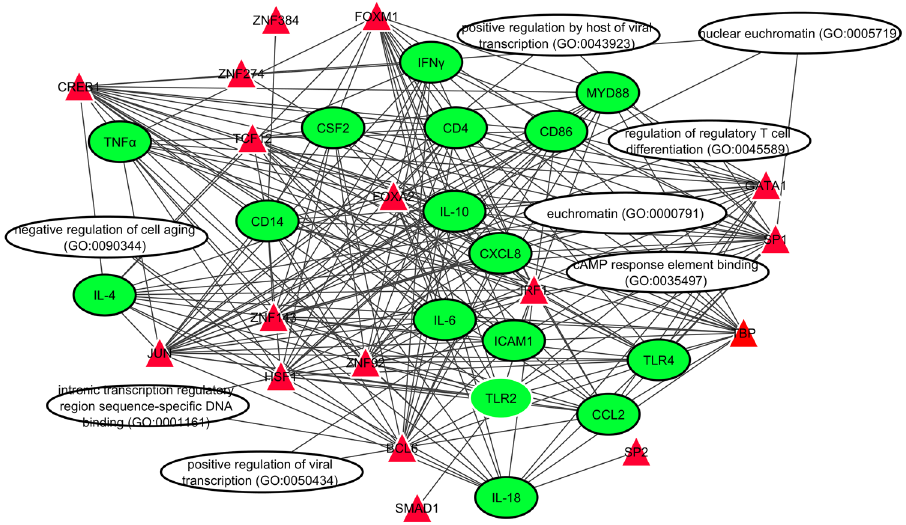
Figure 10. Network interactome of transcription factors (TFs), target genes, and gene ontologies. The red triangles are TFs; green circles are gene targets; while the ovals represent the biological processes, molecular functions, cellular components, and pathways (Cytoscape version 3.7.2; https:// cytos cape.